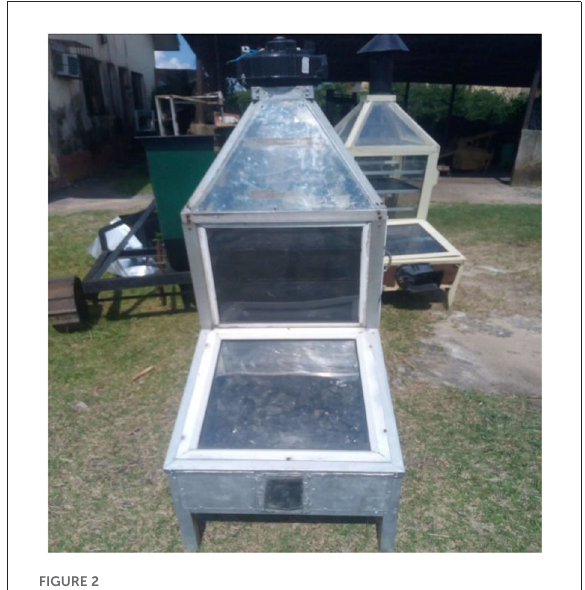
FIGURE2 Locally fabricated solar